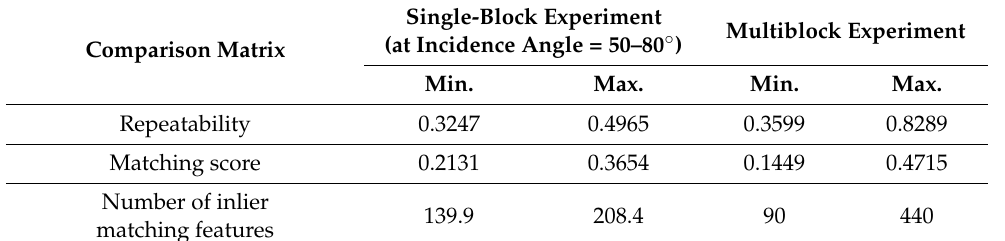
Table 2. Minimum and maximum values for the feature performance evaluation measured from the single- and multiblock experiments.